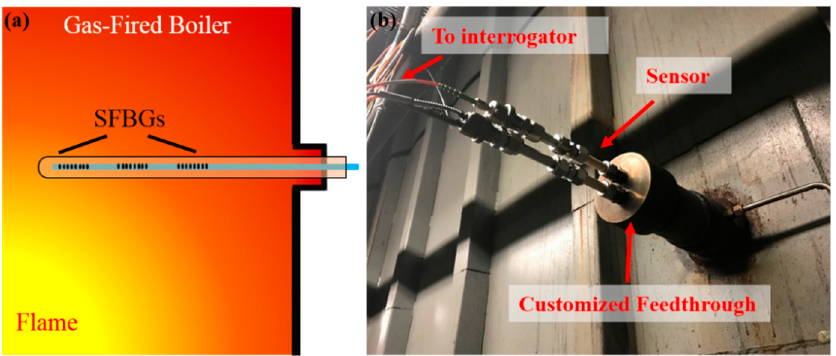
Figure 9. Sensor deployment in a gas-fired boiler: ( a ) scheme for the configuration of the sensor (thermocouple not shown); ( b ) picture of the deployment site.